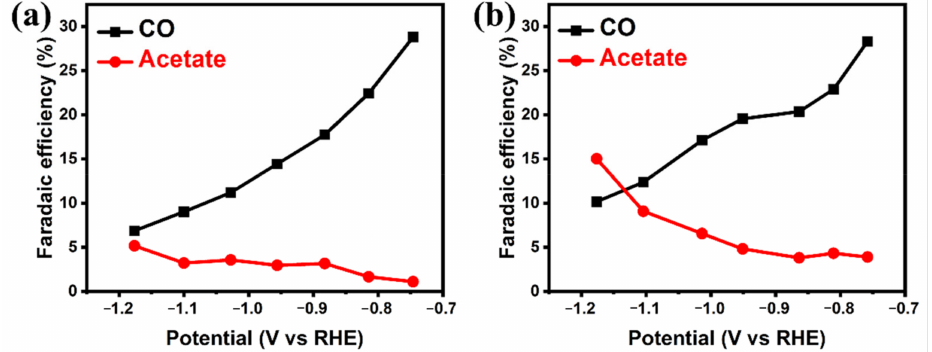
Figure 4. CO and acetate Faradaic efficiencies on ( a ) Cu 2 O and ( b ) Cu 2 O-Ag nanocubes at different applied